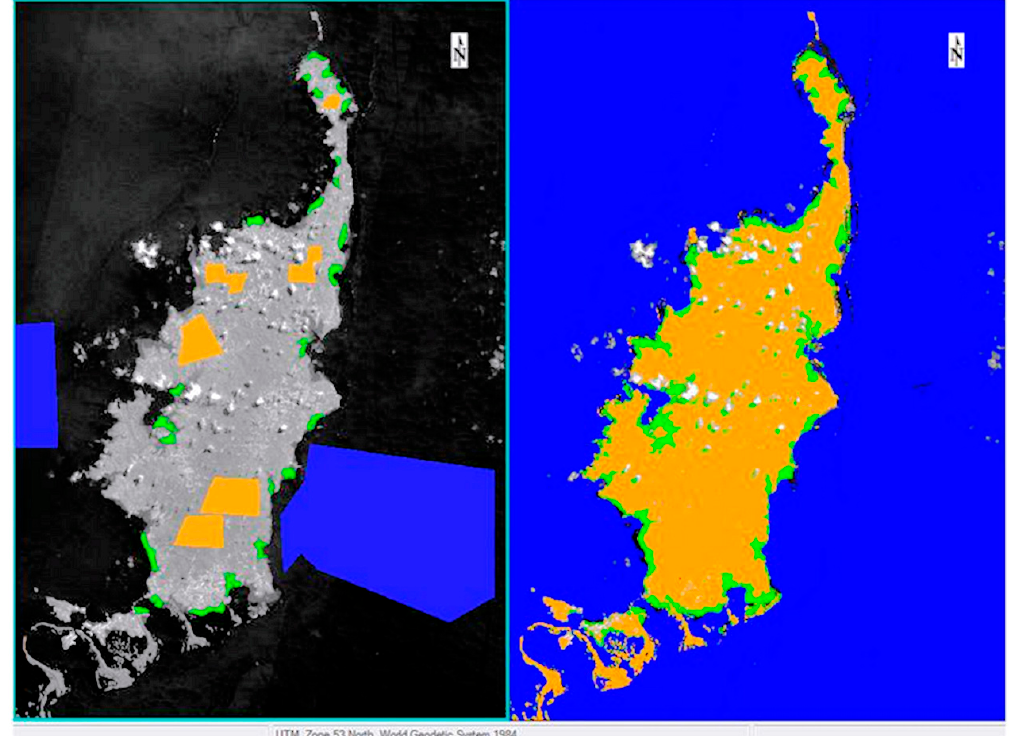
Figure 6. Sentinel-2 satellite image (Band 11) on the Republic of Palau on 4 July 2017, with a 10 m spatial resolution: the ROIs in the process of a ‘supervised classification’ (on the left); the classification result (on the right) where land is orange, the mangrove cover is green, the sea is blue. Clouds are isolated and labelled as unclassified.